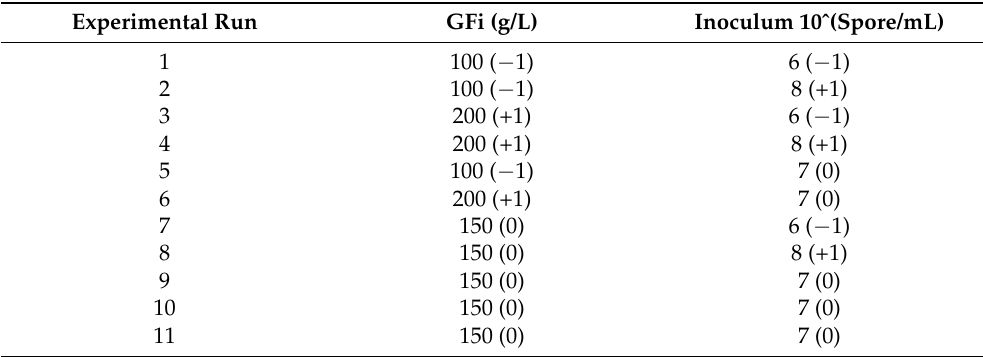
Table 1. The central composite design was applied to experimental variables: initial sucrose concen- tration (GFi) and inoculum concentration. Experimental Run GFi (g/L) Inoculum 10ˆ(Spore/mL) 1 100 ( −